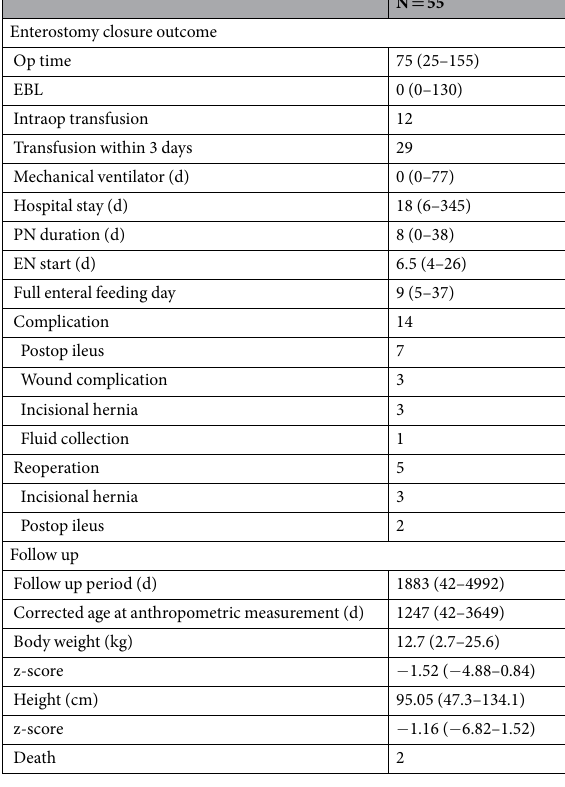
Table 4. Outcome of enterostomy closure. EBL: estimated blood loss, PN: parenteral nutrition, EN: enteral